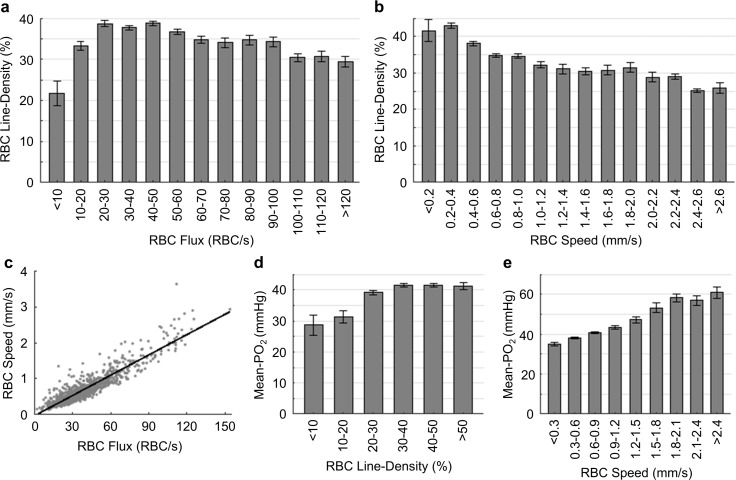
Pairwise relations between capillary RBC flux, speed, line-density and Mean-PO2.The analysis in (a–e) was made with the measurements from 978 capillary segments collected in cortical layers I-V, across n = 15 mice. Data are expressed as mean ± SEM. In (c), the slope of the linear regression line was calculated as ~0.02 mm/RBC (R2 =~ 0.84).